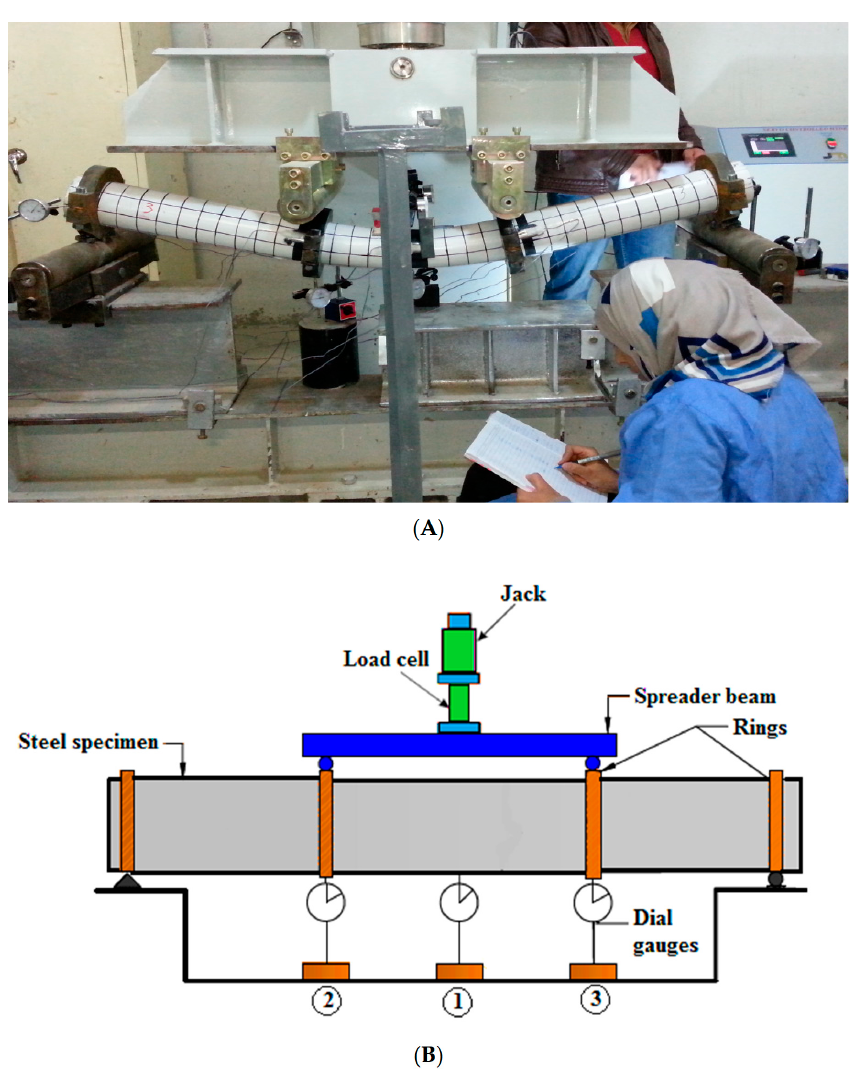
Figure 2. Schematic view of the test device and dial gauges’ distribution: ( A ) experimental, ( B ) numerical. One of the remaining dial gauges was put in the front face (front side) of the specimen and parallel to its center, while the second dial gauge was put in the back face (back side) in order to measure the ovalization deformation of the cross-section at mid-span, as shown in Figure